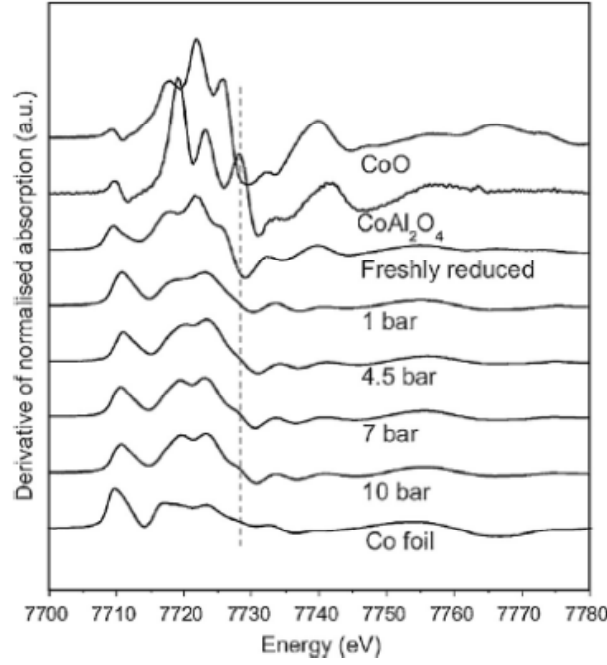
Figure 9. Changes in CO and CH selectivities as a function of conversion over 0.27%Ru- 2 4 25%Co/Al O catalyst (Co cluster size of ∼ 5 nm by hydrogen chemisorption/pulse 2 3 reoxidation) at 220 °C, 1.5 MPa, H /CO = 2.1 and SV = 0.3–15 NL/g 2 permission from [21] Copyright 2011,